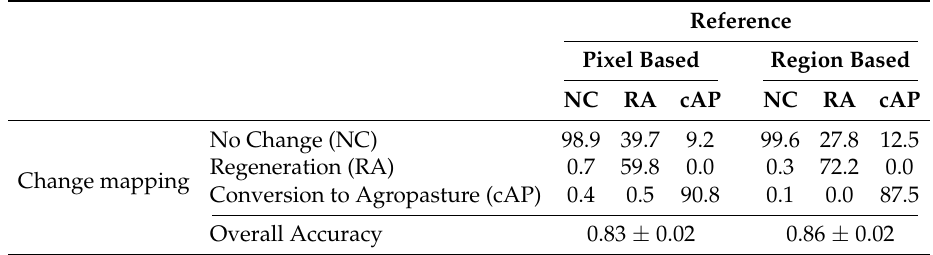
Table 10. Mean rectangular confusion matrices (%) and evaluation indexes for final change mappings using L3 legend.